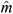
Correction of the modulation index for deviations from the Poisson model.(A) A short segment (0.5 s) taken from: Top—an oscillatory rate function (f
0 = 12 Hz, r
0 = 60 sp/s and m = 0.5). Middle—an example of a Poisson generated spike train from this rate function, without refractory period. Bottom—an example of a Poisson generated spike train with refractory period of 2 ms. The red lines in the middle spike train indicate the missing spikes in the bottom spike train, due to the refractory period. (B) The analytically reconstructed modulation index (m^), as a function of the estimated baseline firing rate (r^0), for spike trains with refractory period. The solid lines indicate the mean estimated modulation; the shaded areas indicate ±1 STD of the reconstructed modulation, and the dashed line indicates the original modulation. (C) The corrected modulation index (mp^) for the same spike trains in B. (D) Reconstruction of the modulation index of GPi neurons after correction of the modulation index. The black line is the linear regression for all the neurons (n = 98, R2 = 0.0005, p >0.5).